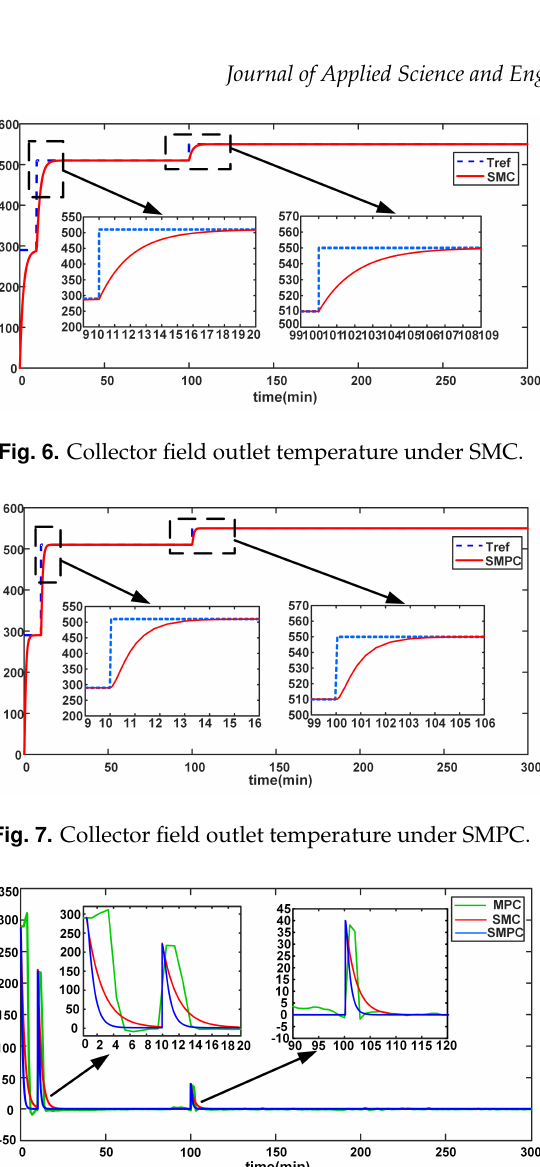
Fig. 8. Comparison of MPC, SMC, SMPC errors.